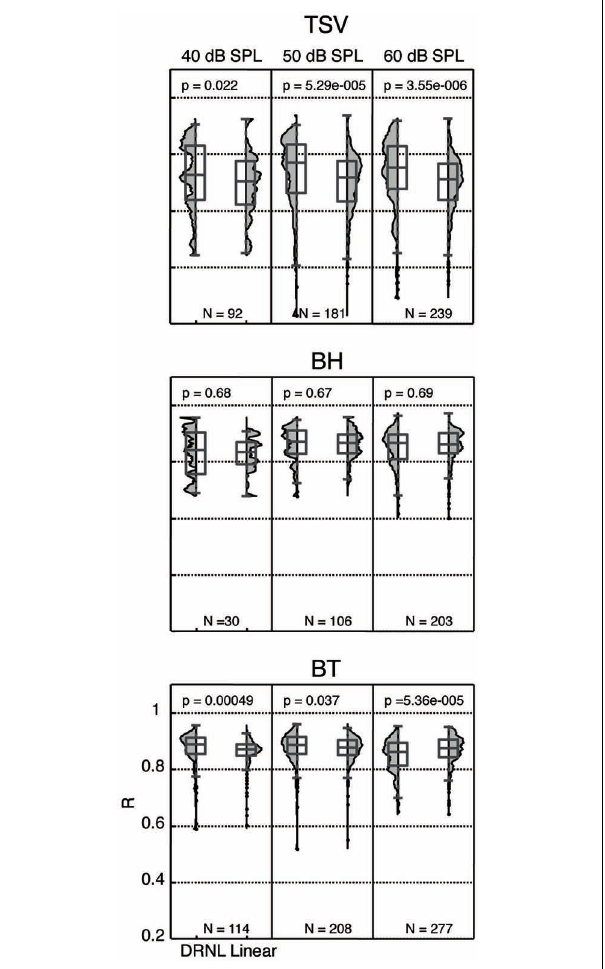
FIGURE 11 | Distribution of correlation values for different levels. The peak correlation values ( R ) are plotted for both the linear path and DRNL outputs for three different stimulus levels for each vocalization from 10 animals.The R values were significantly different between the linear path output and the DRNL output for some cases ( p < 0.05,Wilcoxon rank-sum test). N denotes number of total ICC sites for each